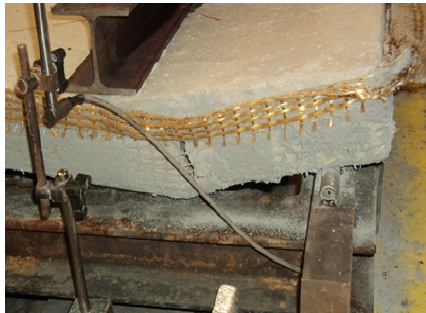
Figure 9: Application of the second layer of PBO with wrapping or- thogonal to the previous